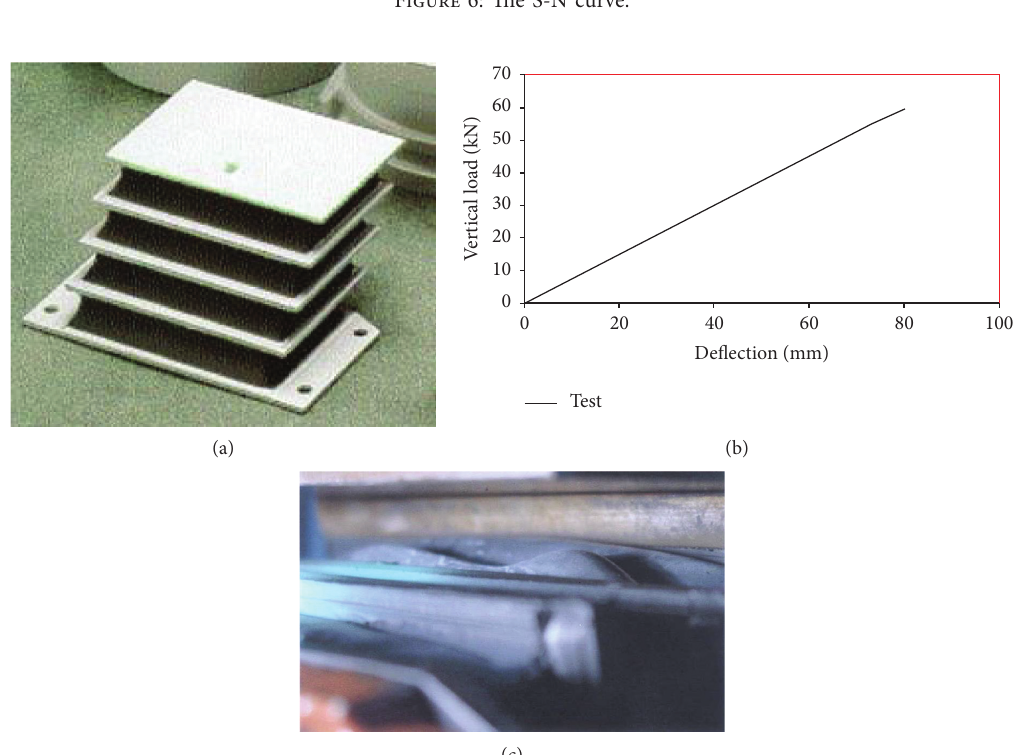
Figure 7: The sandwich mount and its experimental results. (a) The photo of the sandwich mount. (b) The load-deflection curve of the sandwich mount in the vertical direction from the test. (c) The failed sandwich spring at approximately 380K cycles: the hot spot was around the second layer of rubber and close to the